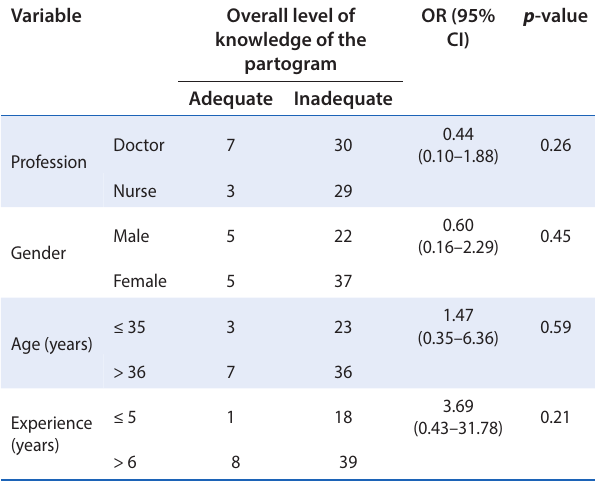
Table 4: Association of knowledge of partogram and demographic variables General knowledge of the partogram